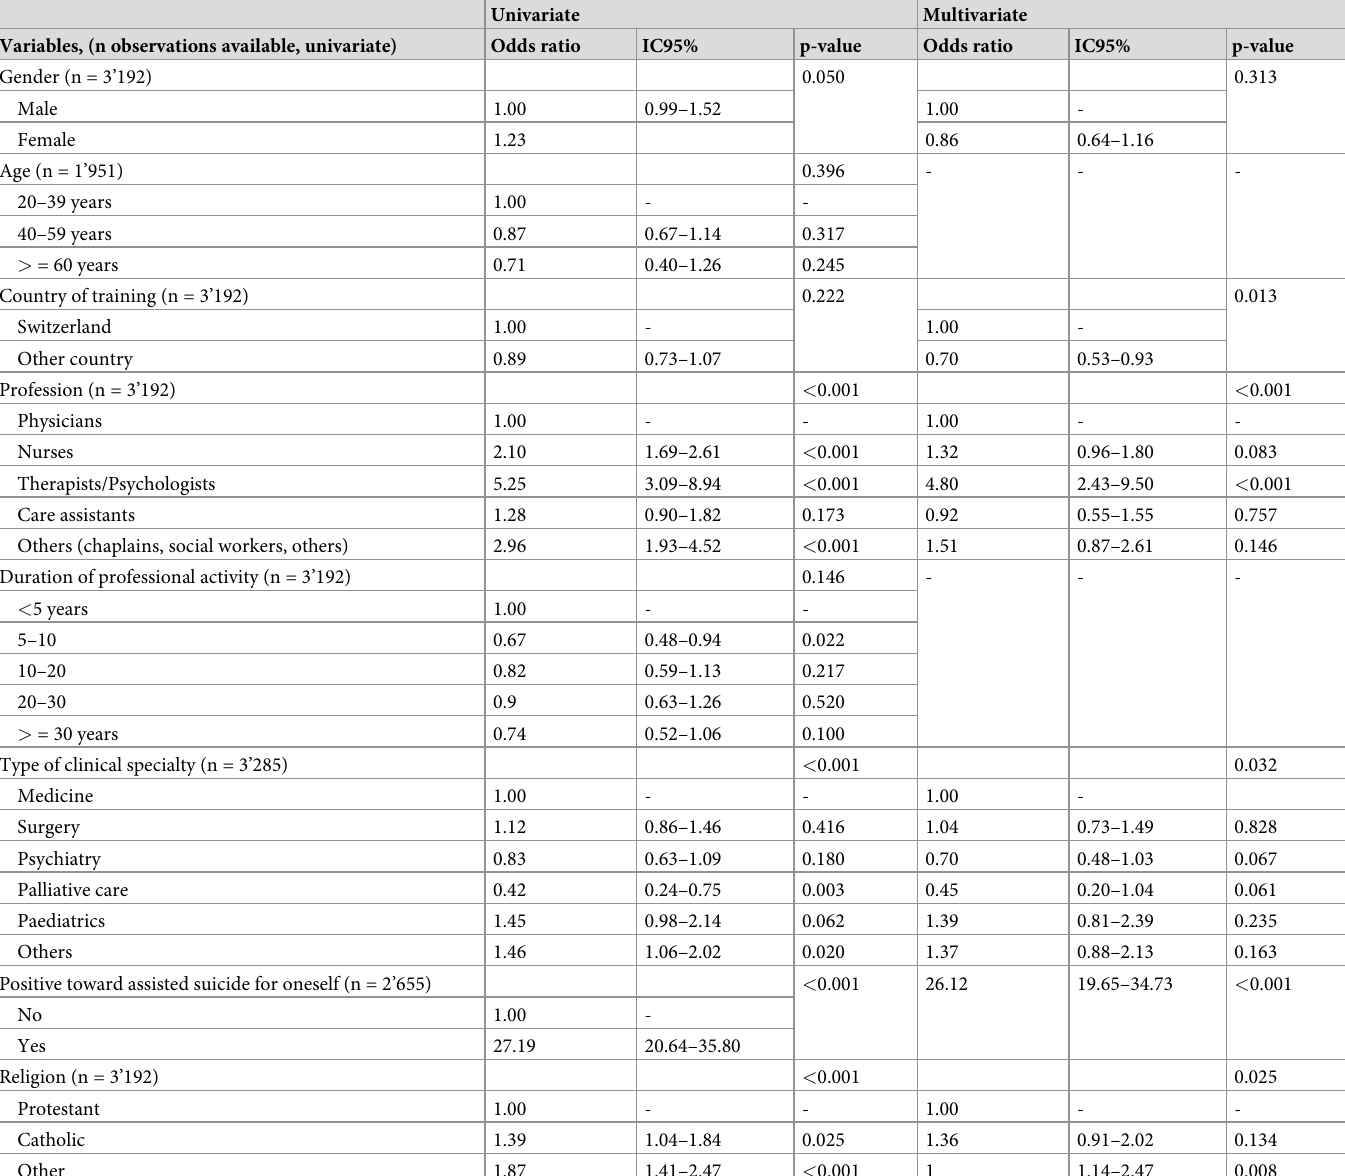
Table 2. Factors associated with favoring the authorization of assisted suicide inside the hospital (univariate and multivariable